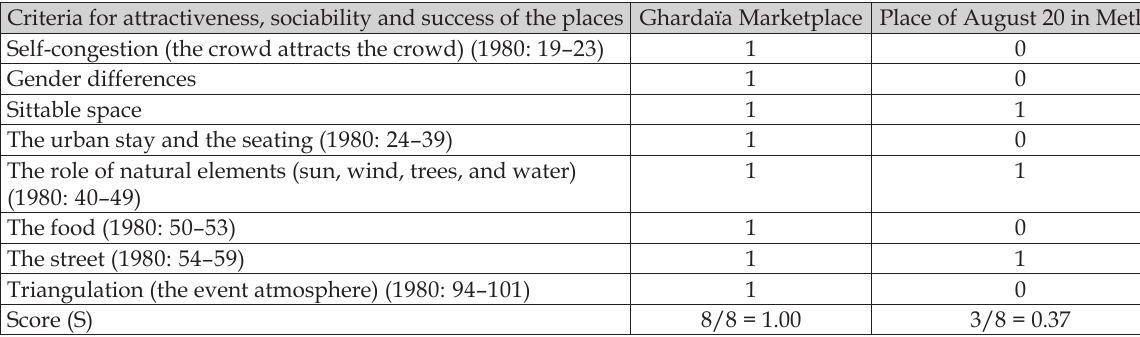
Table 5. Observation grid of attractiveness and social